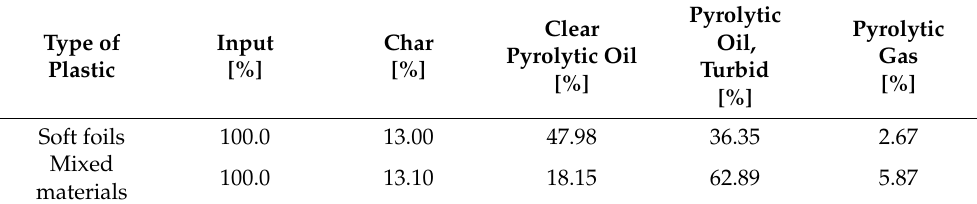
Table 4. Sulfur migration in products.